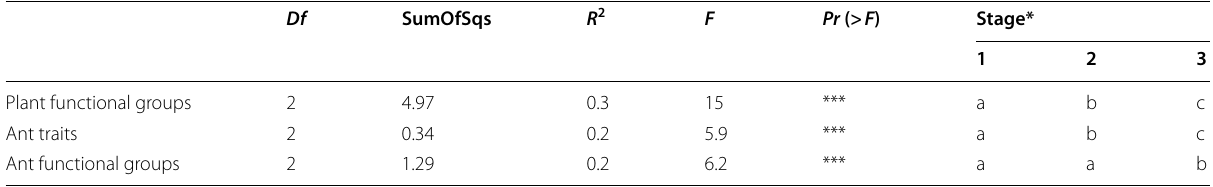
* Data within a row followed by the same letter do not differ at P